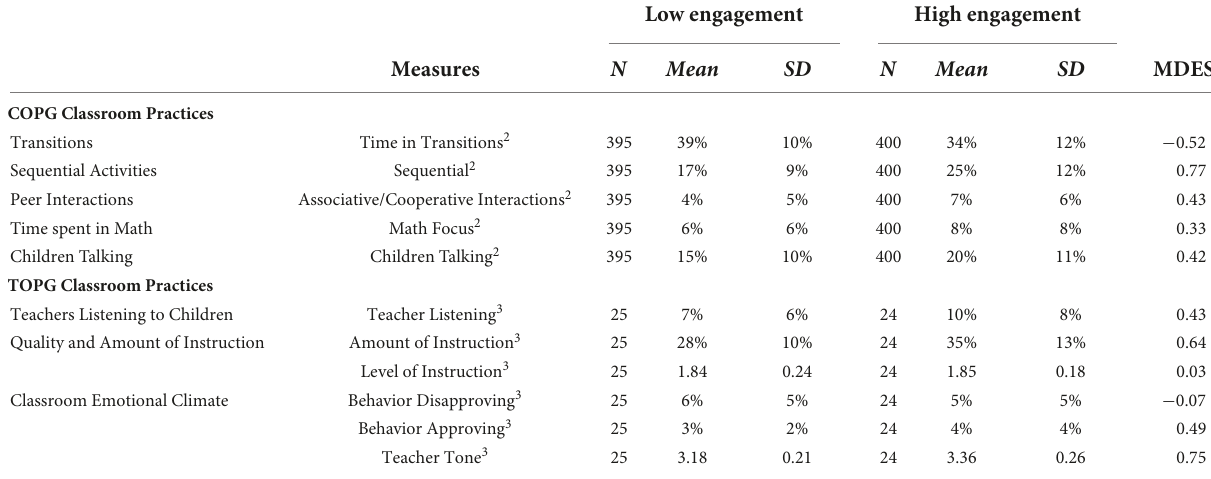
TABLE 4 Effect size differences, comparing classroom practices occurring in classrooms with lower engagement versus higher ratings of student